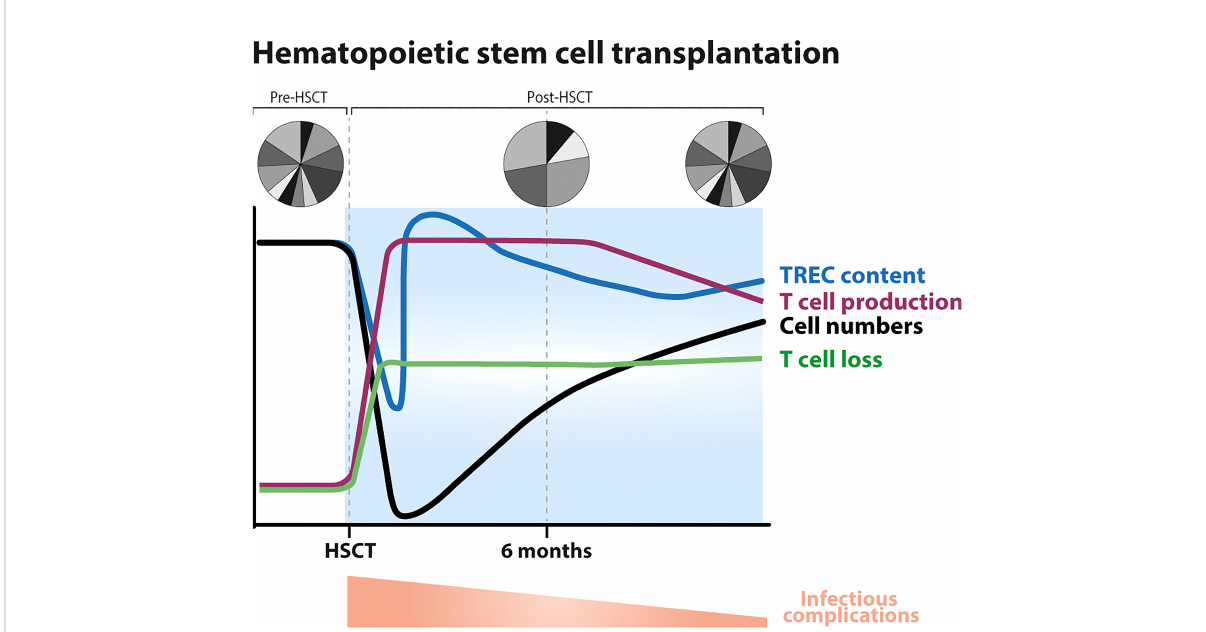
FIGURE 4 Dynamics of T-cell reconstitution following hematopoietic stem cell transplantation (HSCT). Following conditioning, T-cell numbers drastically decline (black line) after which they slowly recover, T-cell production levels increase (purple line), the average T-cell TREC content temporarily decreases (blue line) to then increase (possibly even reaching supra-normal levels) due to an in fl ux of new naive T cells coming out of the thymus, and the TCR repertoire becomes less diverse due to clonal expansions (96, 97). CD8 + T cells typically reach normal levels within 3 – 6 months after HSCT, while the normalization of CD4 + T-cell numbers takes longer, sometimes even longer than 10 years. Total CD3 + T-cell numbers approach the normal range ~18 months after transplantation (19) (black line). T-cell production rates do not clearly correlate with T- cell reconstitution: they may decrease even when T-cell numbers have not yet completely recovered, and may stay higher than in healthy controls in subsets that have already recovered. Thymopoiesis is thought to be restored within 6 months to a year after HSCT, thereafter the TCR repertoire becomes more diverse and slowly normalizes. Full reconstitution of the T-cell pool is hampered by increased lymphocyte